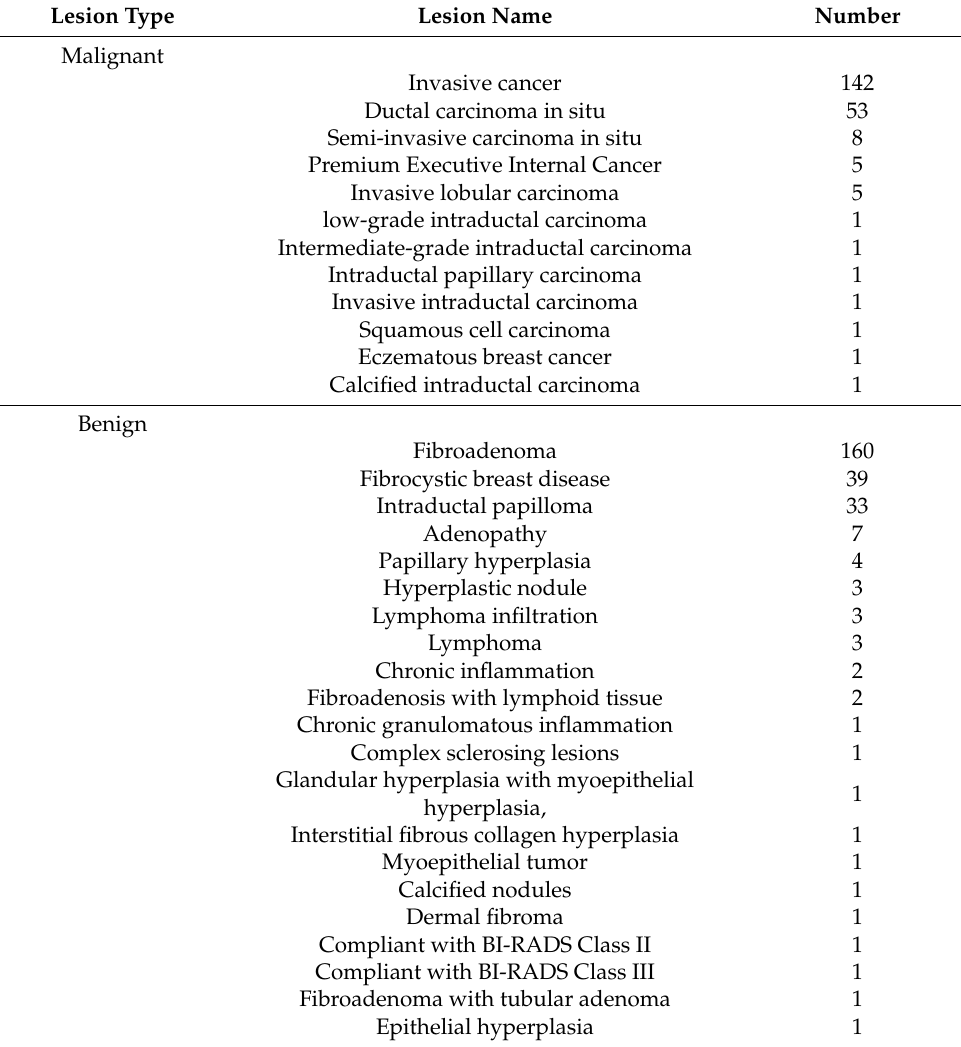
Table 3. Lesion types and